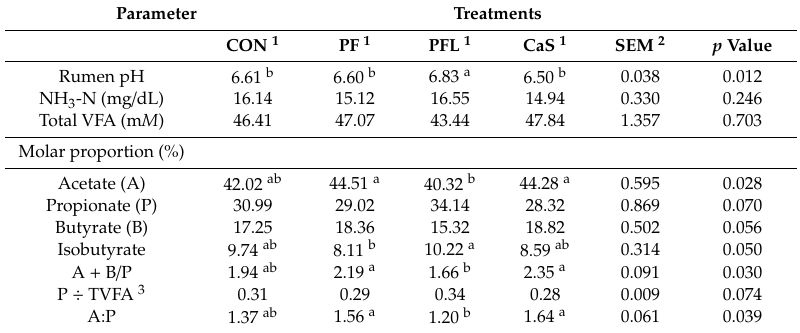
Table 6. E ff ect of di ff erent rumen protected fats on rumen fermentation characteristics in Dorper sheep. Parameter